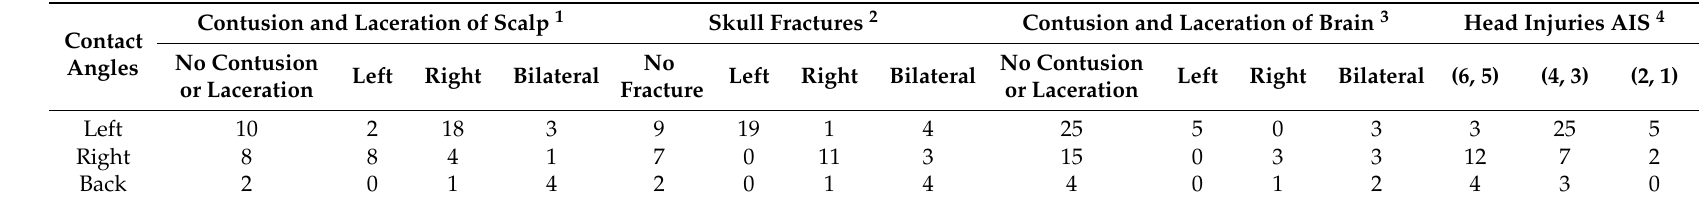
Table 3. Comparison of head injuries at different contact